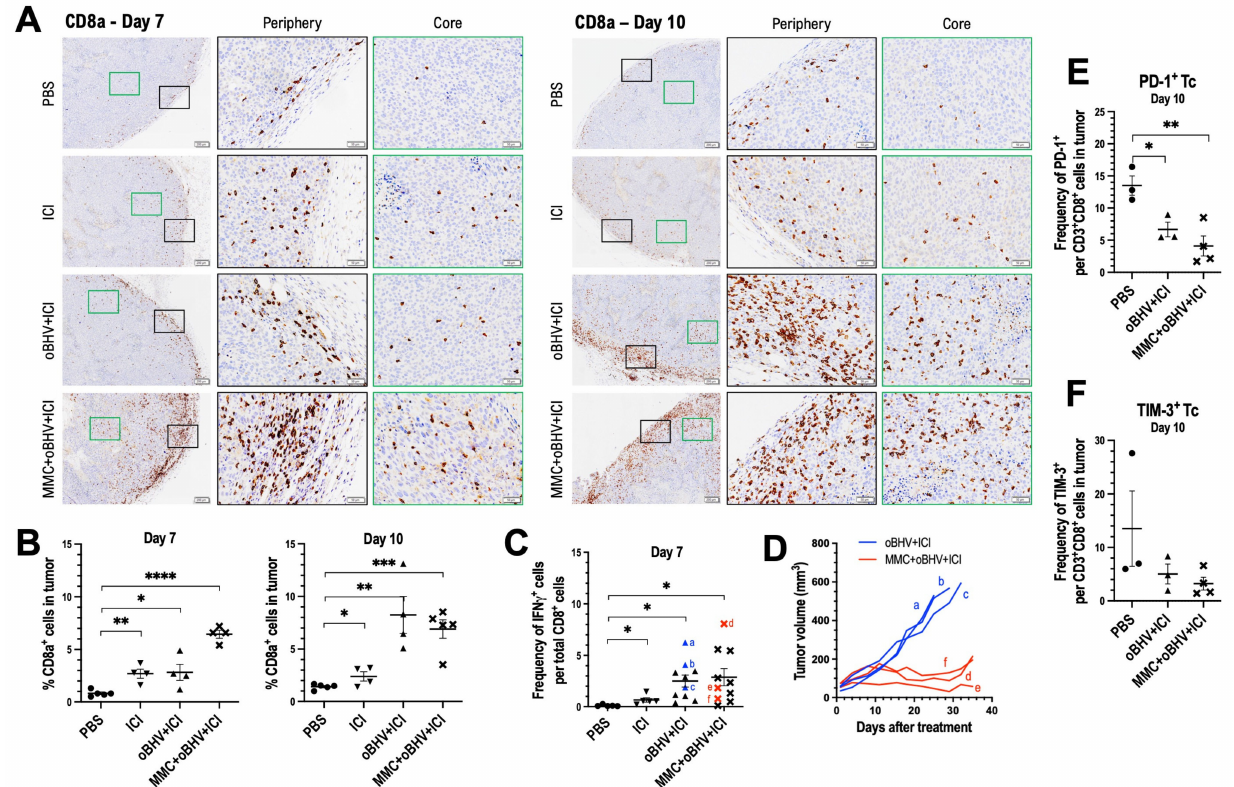
Figure 4. B16-C10 tumors were treated with PBS, ICI, oBHV + ICI or MMC + oBHV + ICI. CD8a IHC was performed on tumors on days 7 and 10 ( A ). Images with 2 × magnification are shown in left panels, and 10 × images of the tumor periphery (black) and core (green) are shown in the center and right panels. Scale bars: 200 µ m (left panels); 50 µ m (center and right panels). Quantification of CD8a + cells was performed over the whole tumor area ( B ). On day 7, blood was collected for IFN γ ICS of peptide-stimulated CD8 + T cells ( C ). Mice shown as red and blue dots identified with letters a–f in C were monitored for tumor growth ( D ). To evaluate the level of exhaustion of CD8 + TILs (Tc) on day 10, tumors were processed and TILs were stained for analysis via flow cytometry ( E , F ). * p < 0.05, ** p < 0.01, *** p < 0.001, **** p <